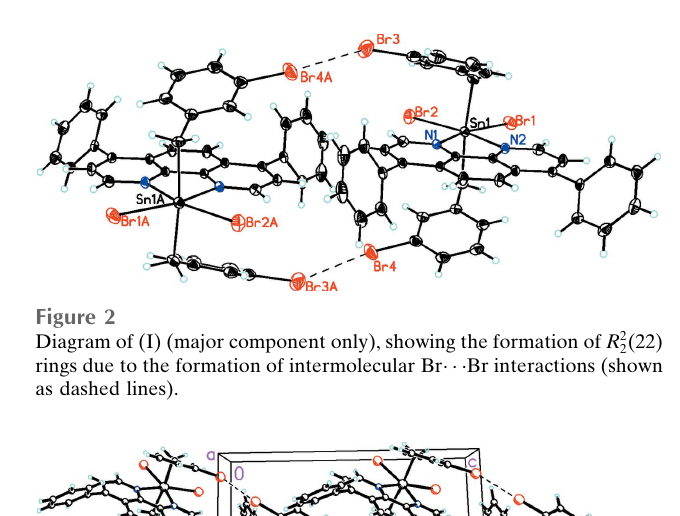
Figure 1 The molecular structure of (I), showing the folding of the 3-bromobenzyl rings in order to form (cid:2) – (cid:2) interactions with the 4,7-diphenyl-1,10- phenanthroline ligand. Displacement ellipsoids are drawn at the 30% probability level.